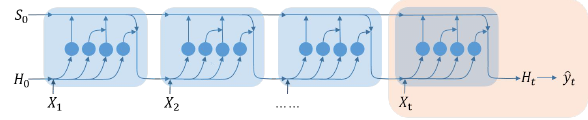
Figure 3. A neural unit of ConvLSTM network when X t is input.